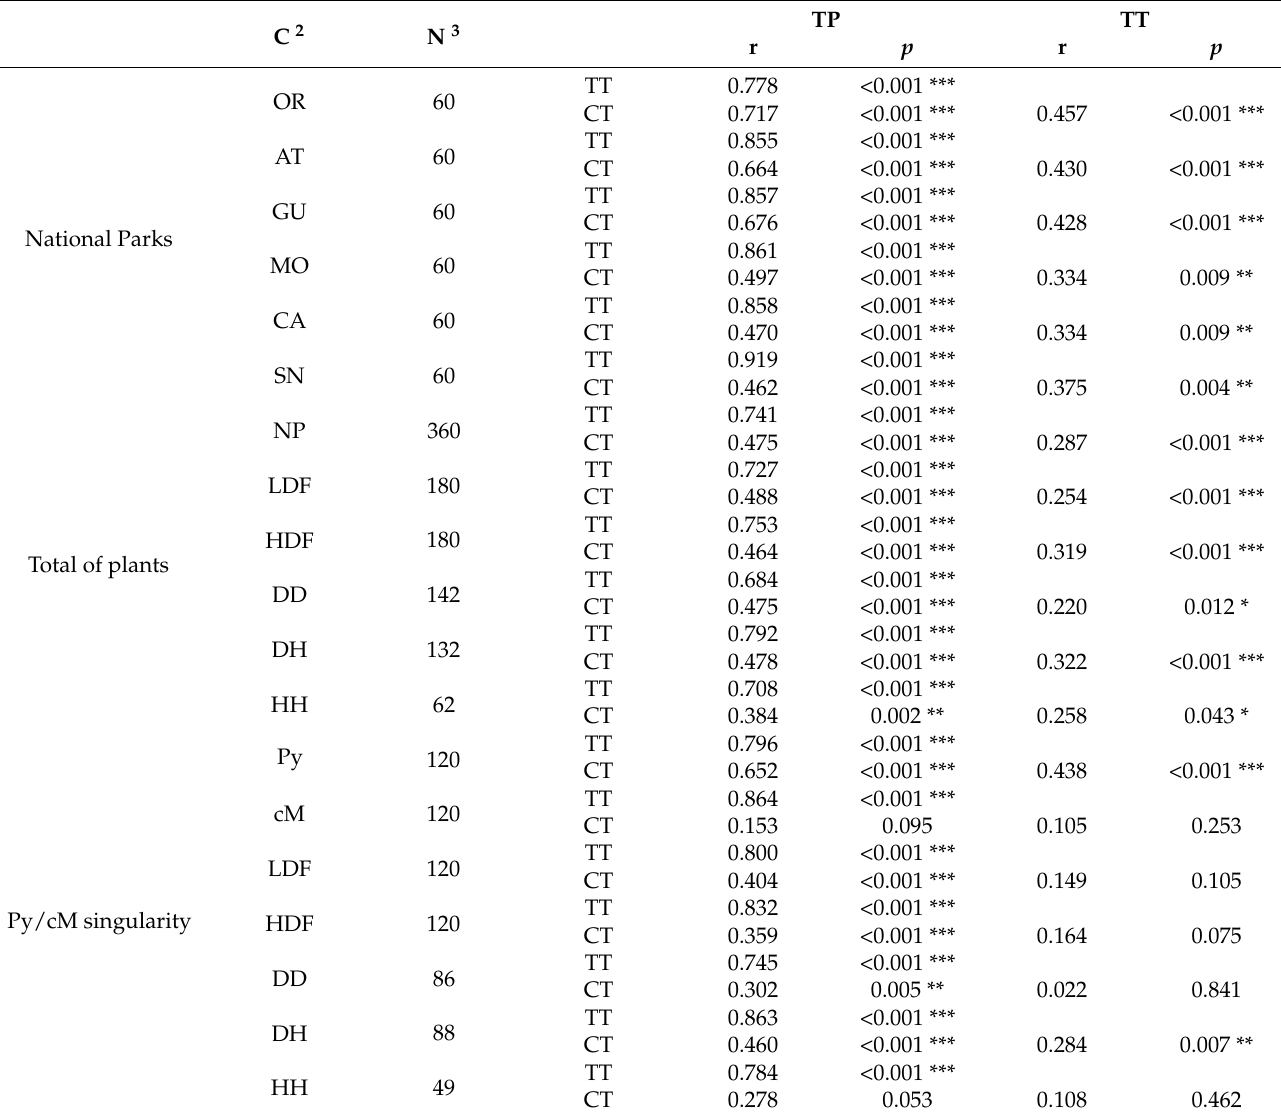
Table 4. Linear regression 1 between tree defenses: effects of biogeographical, ecological, and gen- etic